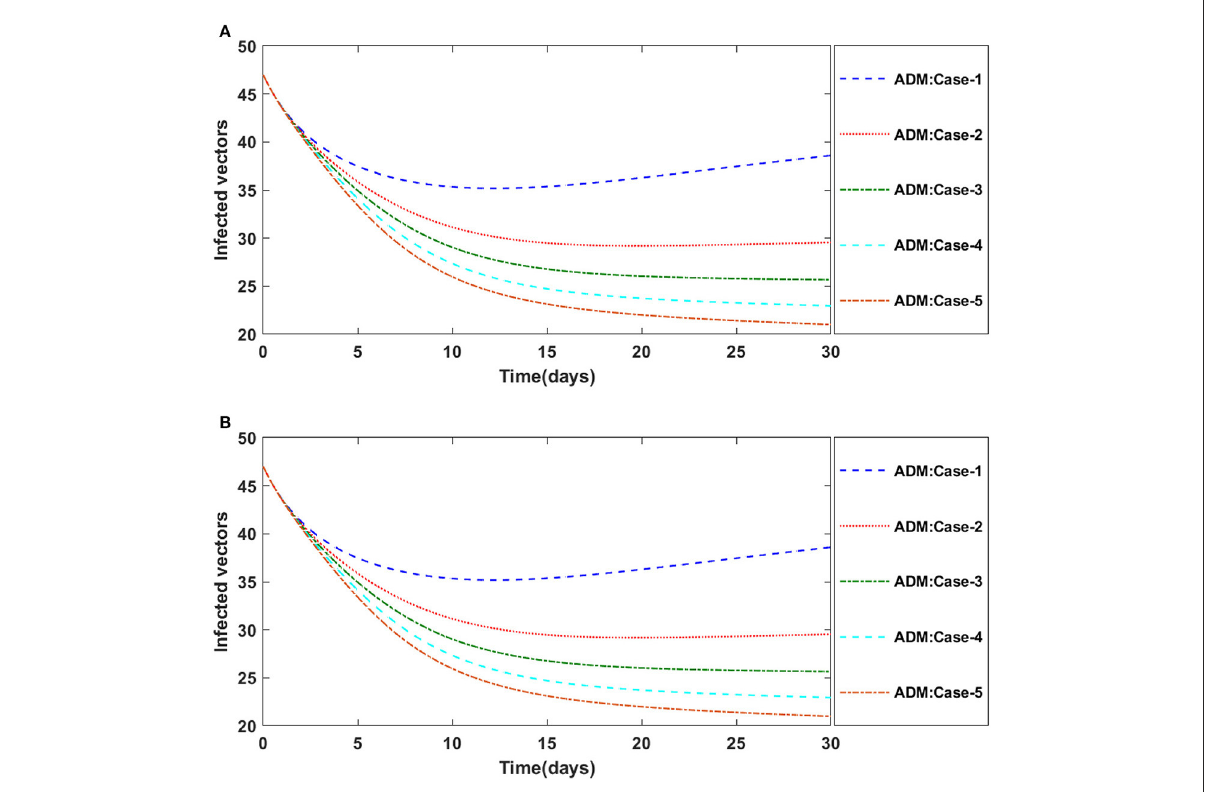
FIGURE13 (A) Dynamics of infected vectors for the varition in γ using ADM for model A2. (B) Dynamics of infected vectors for the varition in γ using ADM for model A2.